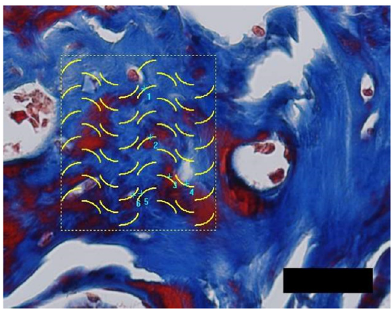
Figure 7: Representative images from the stereological analysis. Ninety - six cycloids were counted from the image and only six intercepted some osteocytes ( scale bar = 15 µm, 40 × magni fi cation ) . Image cut from the Blue Bone ® group.